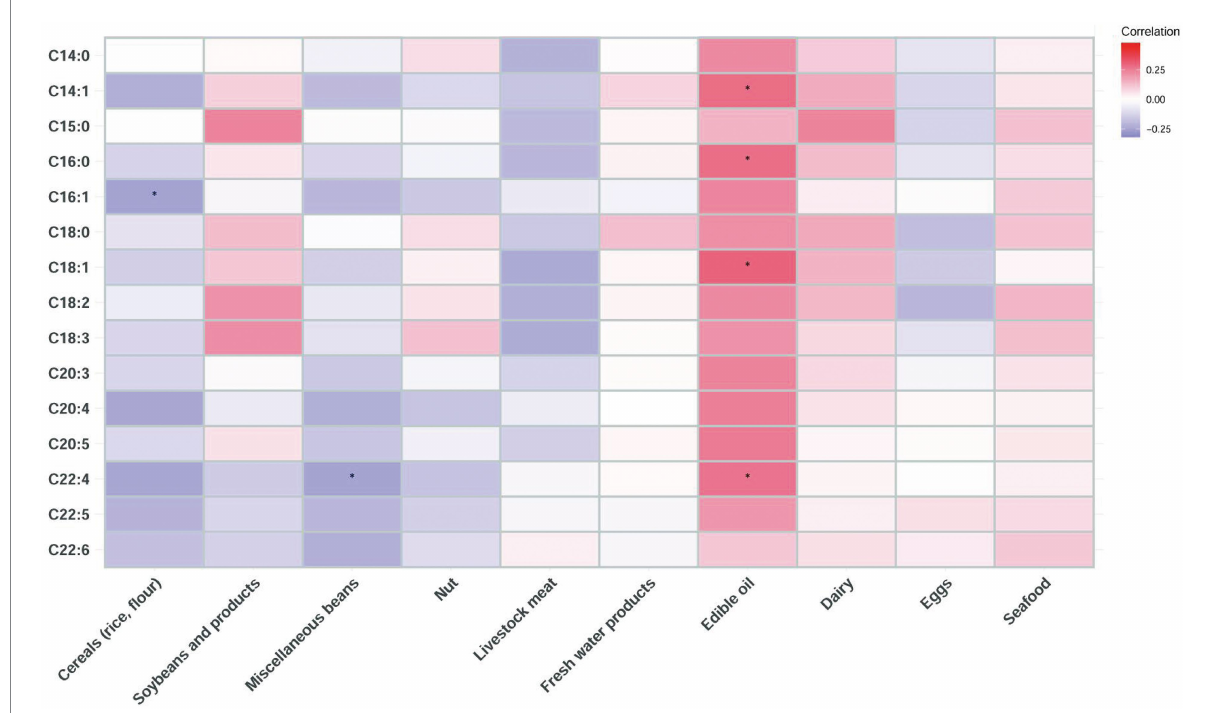
FIGURE 1 Correlation heatmap of the long-chain FA content in human milk and the food contribution rate of fat intake of lactating mothers based on Spearman analysis (* indicates p <